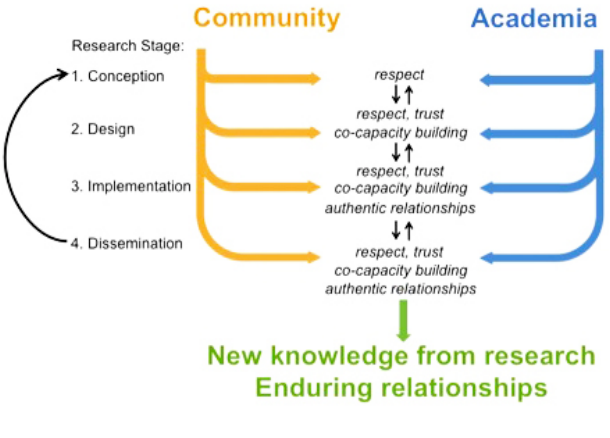
projects, which are generally resourced better and operate on time frames over which respect and trust can be more effectively cultivated and maintained. This does not imply, however, that smaller projects cannot incorporate engagement as they occur. Fig. 1. Research outcomes (green) and reciprocal process benefits (italicized font) generated through an engaged research process. Through each stage of research, community and academic partners can cultivate benefits, including respect, trust, co-capacity building, as well as open and enduring relationships. These benefits may feed back to previous stages. This allows for a dynamic research process and provides a foundation on which successive stages are